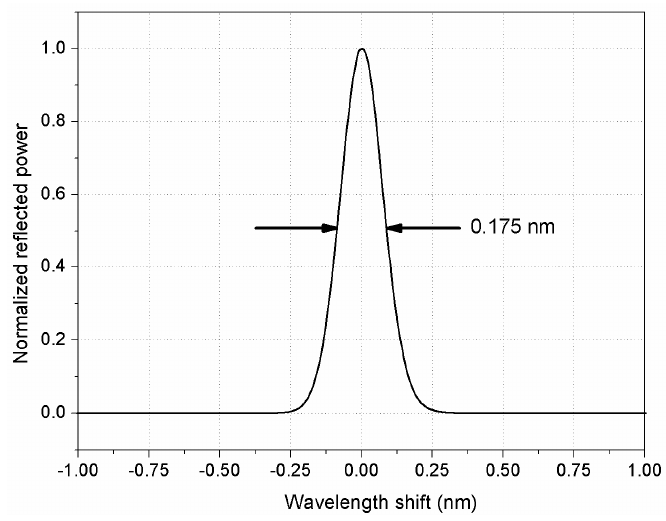
Figure 1. Spectrum and band-width of the simulated fiber Bragg grating (FBG) formed by the tunable filter and the fiber mirror.